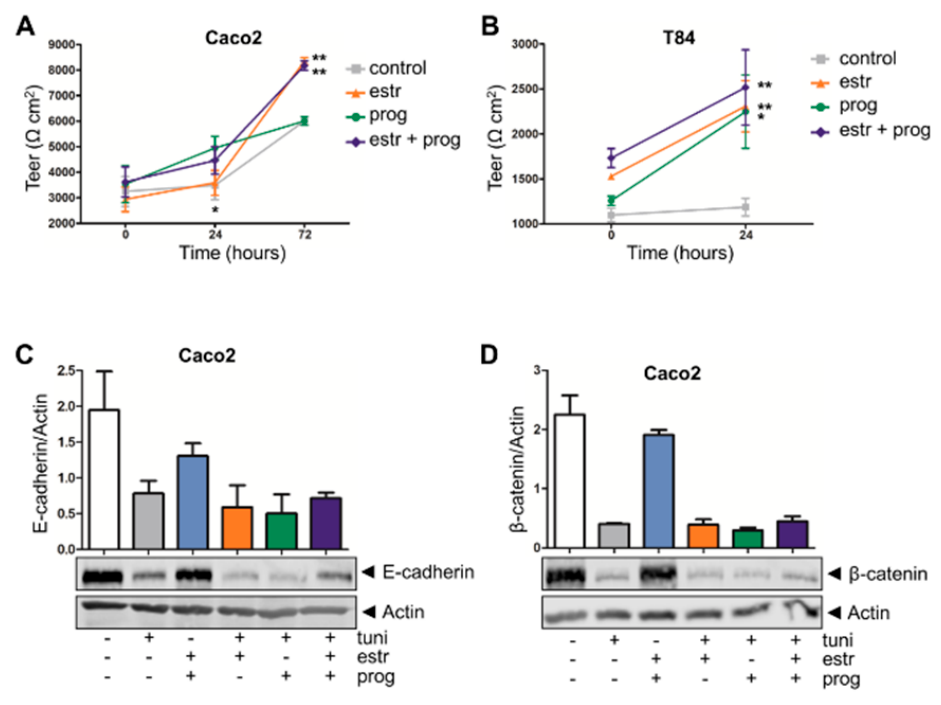
Figure 4. Sex hormones improve epithelial barrier function. Transepithelial electrical resistance (TEER) measurement of Caco2 ( A ) and T84 cell lines ( B ) show an increase in resistance when stimulated with sex hormones. Results of five independent experiments are shown. ( C , D ) Western blot analysis of the adhesion junction molecules E-cadherin ( C ) and β -Catenin ( D ). Neither constitutive levels nor stress-induced decreases in E-cadherin or β -Catenin levels are modulated by sex hormones. Upper panels show densitometry values (corrected for actin levels in the same lane) of two independent experiments; lower panels show representative examples. */** statistical significant ( p <